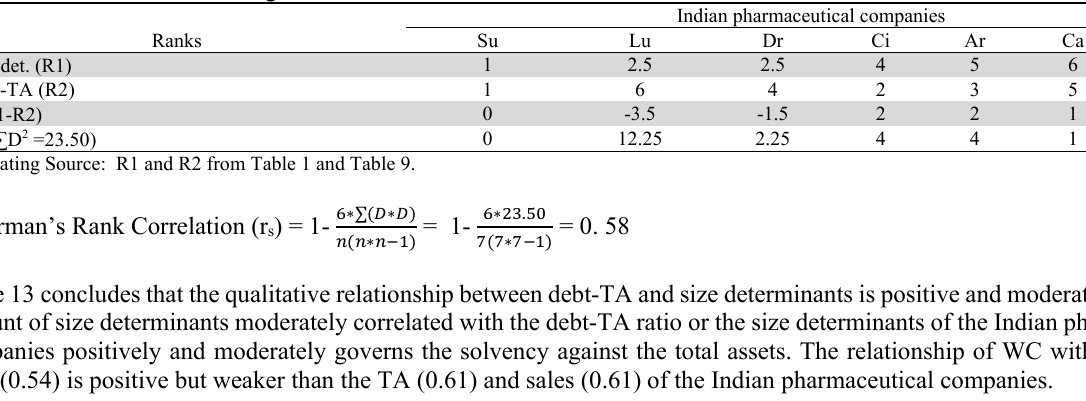
Table 14 Summary of qualitative correlation between size determinants and solvency Ratio Correlation of ranks of size determinants and debt-equity, debt-TA ratio TA WC Sales Originating source: Rank Correlation co-efficient from the table 4 and